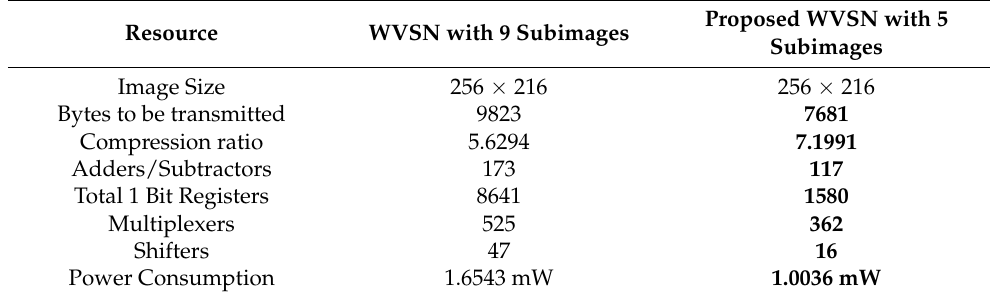
Table 1. Comparison of hardware resource utilization between the proposed WVSN with five subimages and nine subimages.